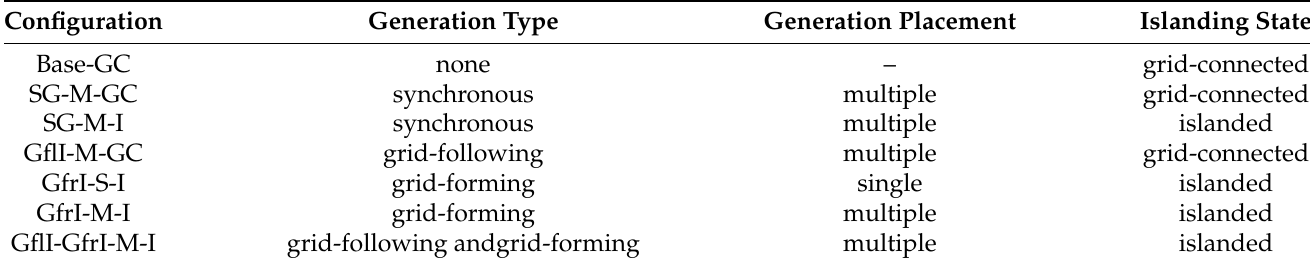
Table 2. Summary of case study